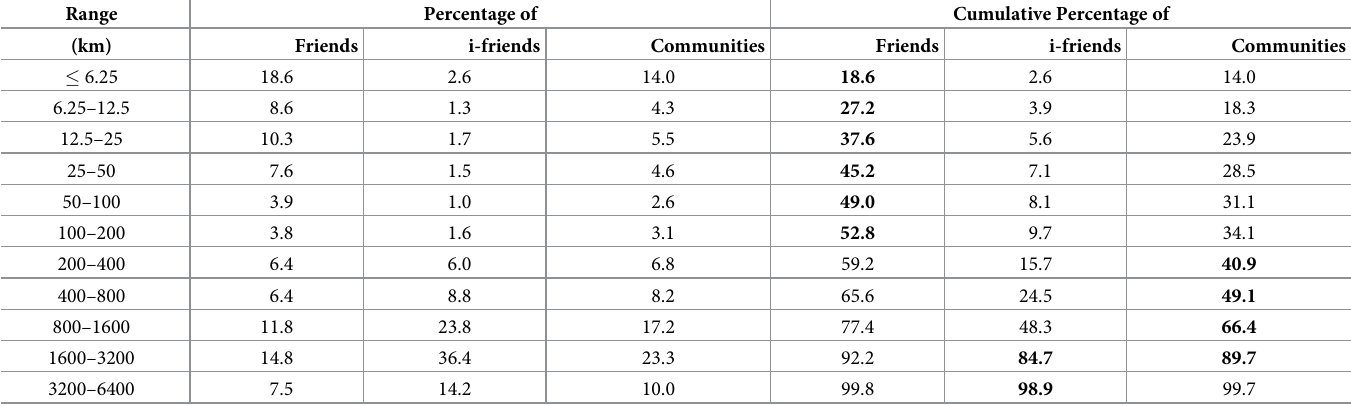
Table 2. Distributions of fractions of friends, i-friends and communities over the ranges of distances from nodes. The second column shows the fractions of friends at each distance range, computed by summing the numbers of friends in each range for each individual user and then dividing the result by the total number of friends of all users. The third column shows fractions computed as ratios of sums of the numbers of i-friends of each user at each distance range to the total number of i-friends for all users. The fourth column shows fractions of members of communities of each individual user at each distance range listed, computed as the sum of these numbers divided by the total number of members of all relevant communities. Fifth, sixth and seventh columns list cumulative values from the second, third and fourth column,